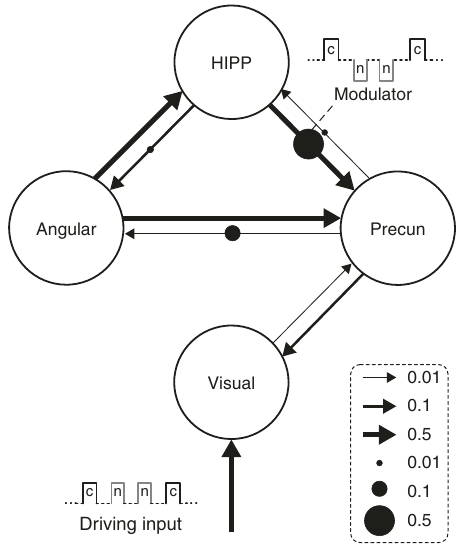
Fig. 4 Winning model of DCM analyses considering modulations effect. This is the winning model of the space de fi ned by adding modulators to the intrinsic connectivity model. Connectivity, driving input and modulator are coded in the thickness of line, and the size of arrow and circle, respectively, representing their effect size (c: continuing news clip, n: naïve news clip). HIPP = Hippocampus; Precun = Precuneus; Angular = Angular gyrus